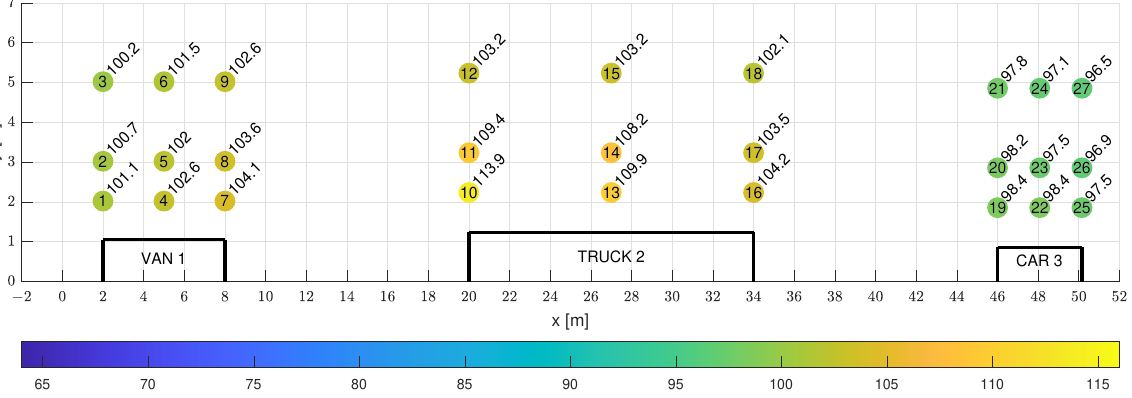
Figure 20. Overall sound pressure level in decibels (dB) on the side of the platoon, measured at receivers for the z-coordinate of 1.7 m. Spacing between trucks: 12 m. View from the top. On the basis of the analysis of the results (Figure 20) of the presented distributions of the overall sound pressure level for the column of cars, we can state that the highest levels occur at a distance of 1 and 2 m from the truck, i.e., at points 10, 13, 11. The lowest levels of overall sound pressure level for the distance of 12 m between the vehicles were observed in the last section, i.e., at points 25, 26, 27. In addition, the biggest difference in overall sound pressure levels was observed between points 10 and 12 and it was 10.7 dB, and the smallest difference was 0.6 dB between points 19 and 21.